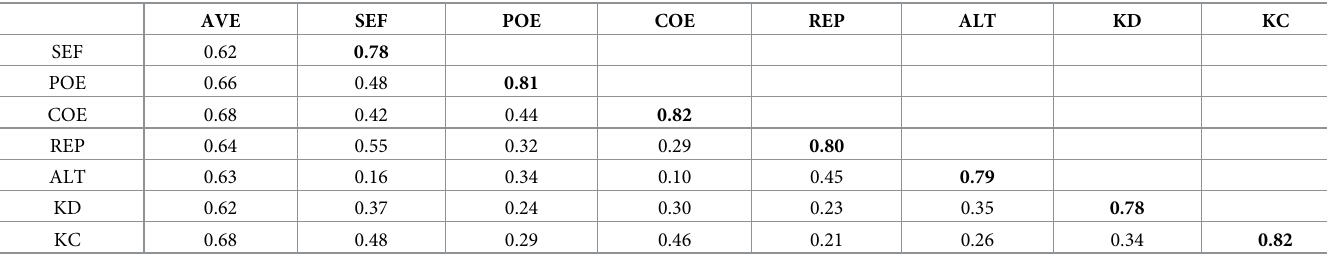
Table 4. Inter-item correlations.